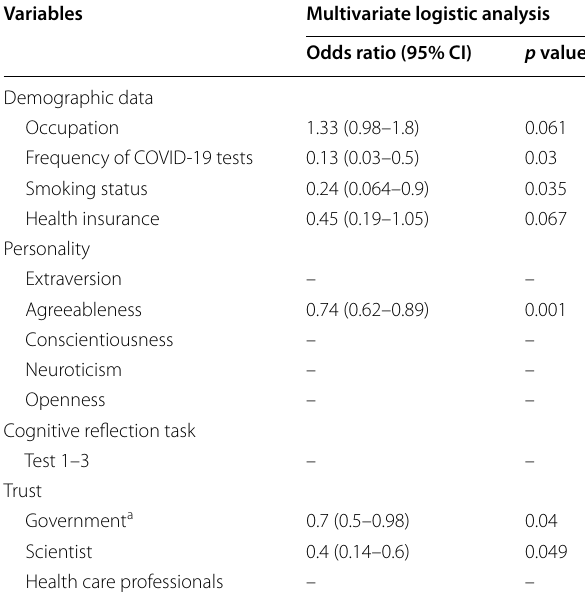
Table 3 Multivariate analysis of demographic factors and physiological indicators amongst vaccine acceptance, vaccine hesitancy, and vaccine resistance